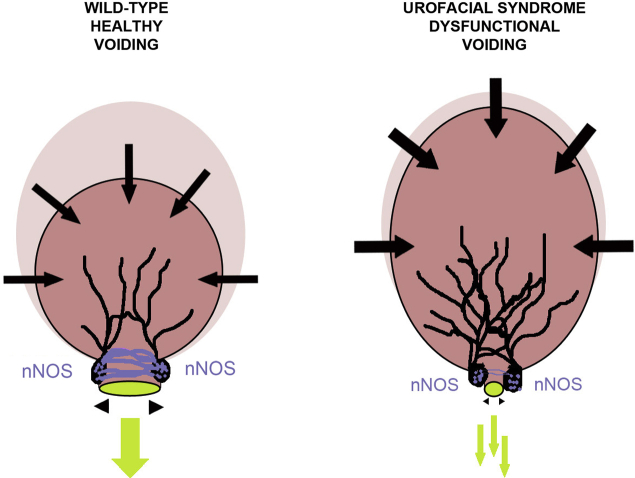
Dysfunctional voiding in urofacial syndrome (UFS). In the healthy bladder (left) a robust urinary stream and efficient emptying are facilitated by full dilatation of the outflow tract–driven neuronal nitric oxide synthase (nNOS) nerves. In the UFS bladder (right) the stream is poor because the outflow fails to fully dilate, which is associated with downregulated nNOS. The detrusor muscle in the body of the UFS bladder is overactive, which is associated with an abundance of nerves in the body of the organ. Contractile forces in the bladder body are shown by black arrows facing inward, and outlet dilatation is shown by black arrowheads facing outward. Nitrergic (nNOS) autonomic nerves around the outflow are depicted in purple, and those in the body (presumed cholinergic) are depicted in black. Urine is depicted in light green. The body of the uncontracted bladder is represented in lilac, and the voiding bladder body is shown in pink.